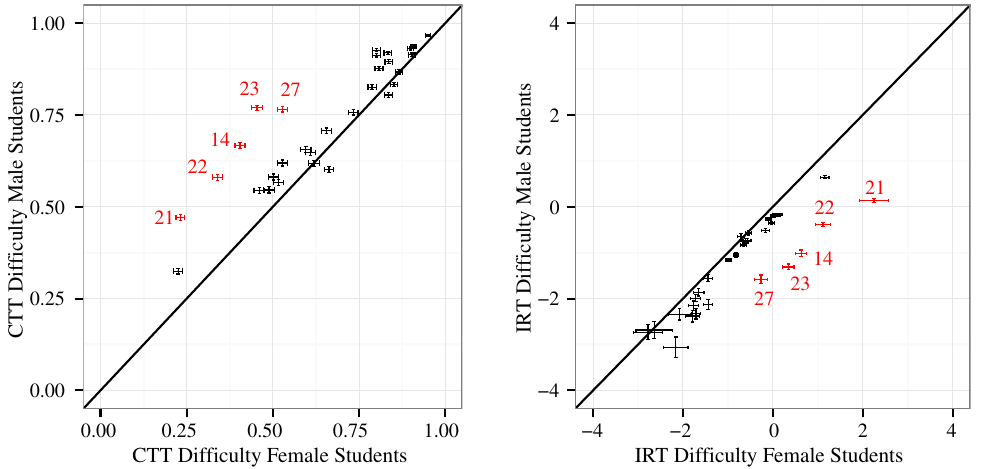
FIG. 1. CTT and IRT post-test results for Sample 1. Items 14, 21, 22, 23, and 27 are marked in red and labeled. A line of slope one is drawn to allow comparison of male and female difficulty. Error bars represent 1 standard deviation in each direction.